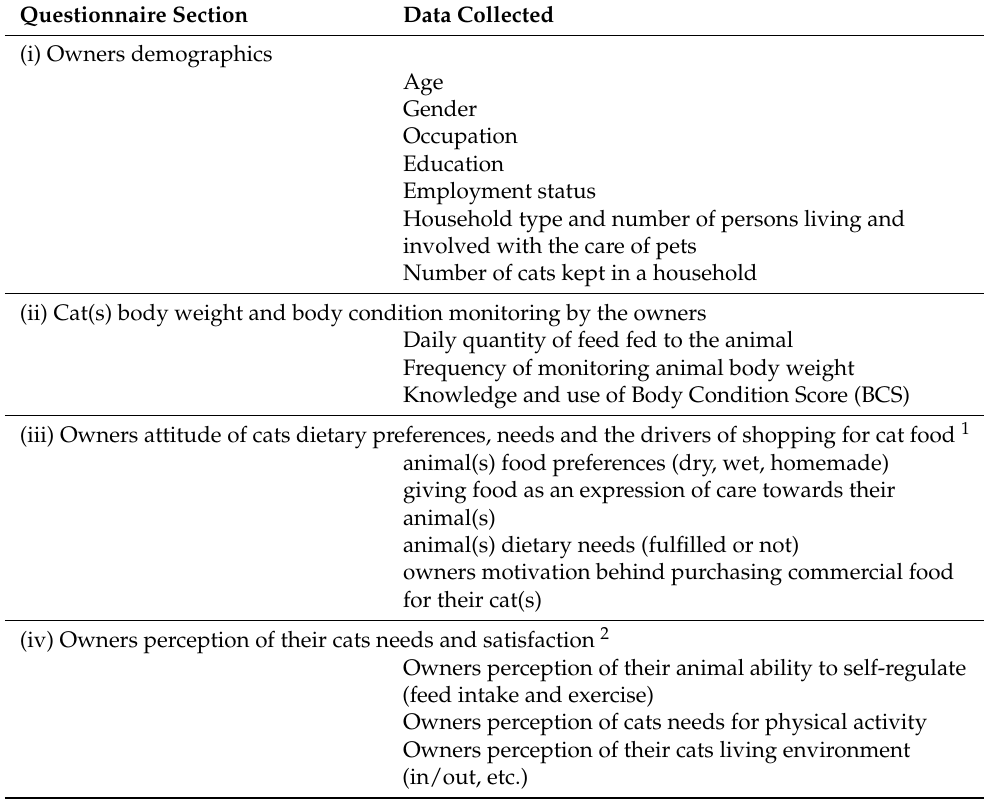
Table 1. An overview of the questionnaire used in the study. Questionnaire